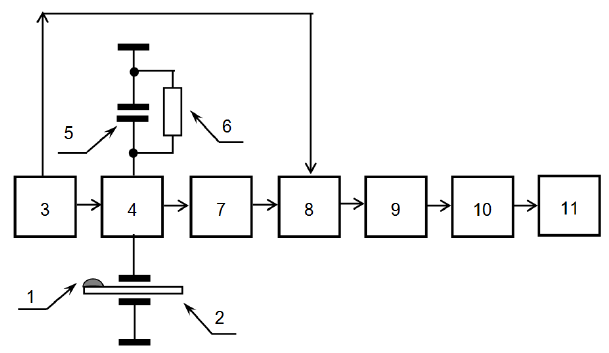
Figure 4. Functional diagram of the device: 1—drop; 2—sensor; 3—generator; 4—bridge circuit;